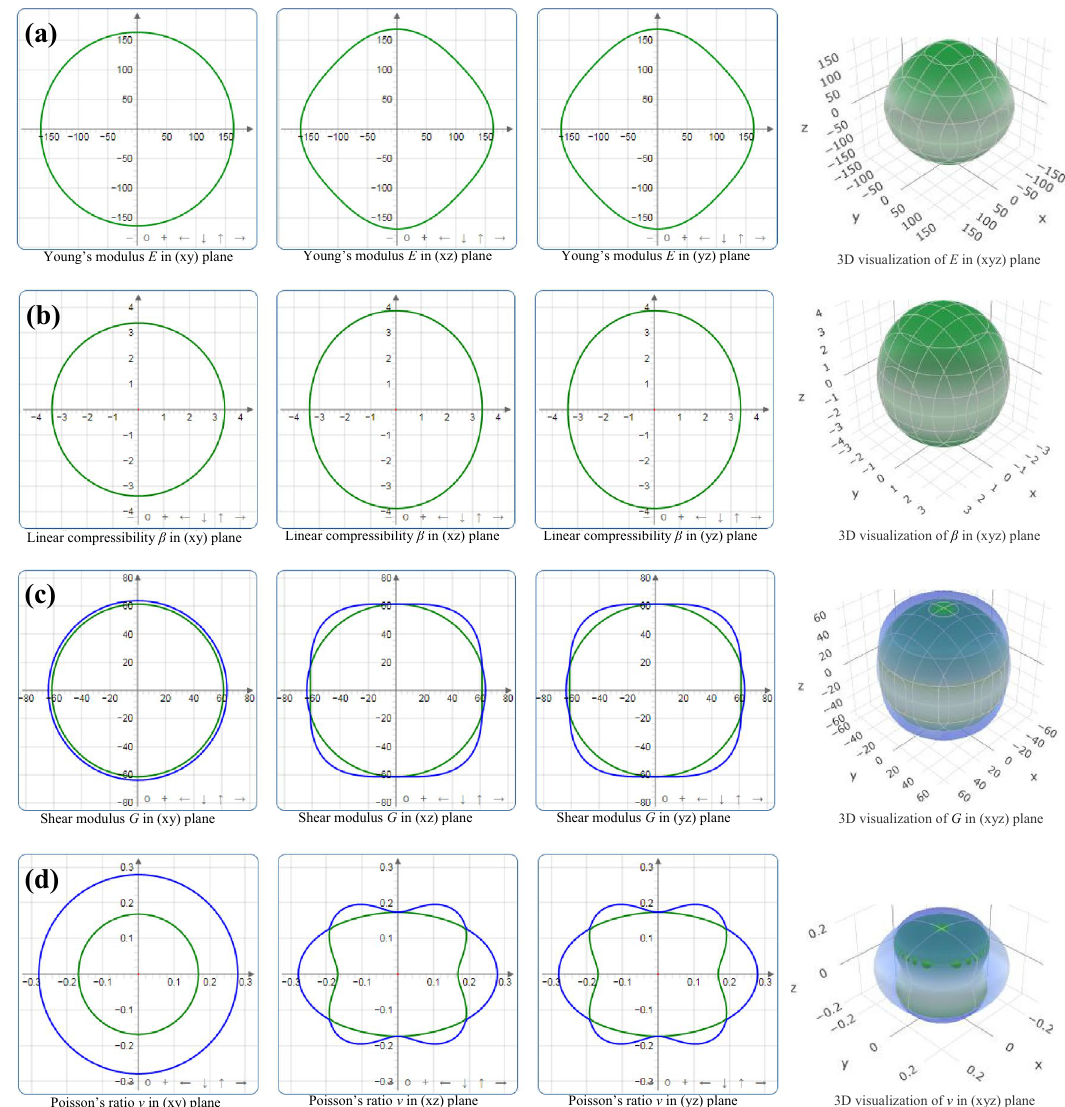
Figure 5. Directional dependence of ( a ) Young’s modulus E , ( b ) linear compressibility β, ( c ) shear modulus G and ( d ) Poisson’s ratio ν of Sc 2